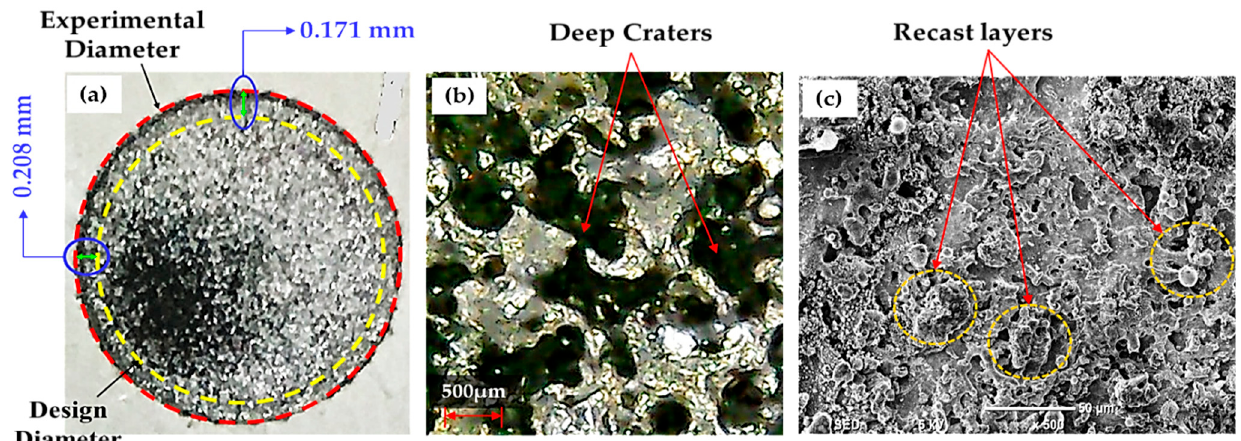
Figure 12. Experimental results obtained for the Cu-electrode and PTR = 1.5: ( a ) machined surface of workpiece; ( b ) micrograph of Ti-6Al-4V showing the presence of deep craters on the workpiece surface; ( c ) recast layers occurred on tool surface.